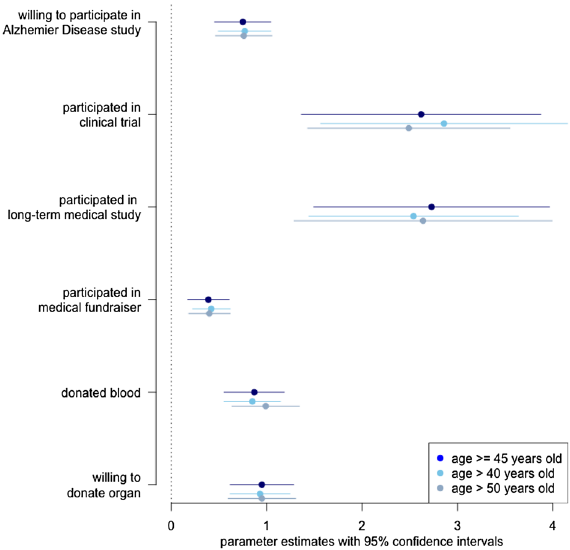
Figure 2. Discrimination parameters from IRT model of participation in medical